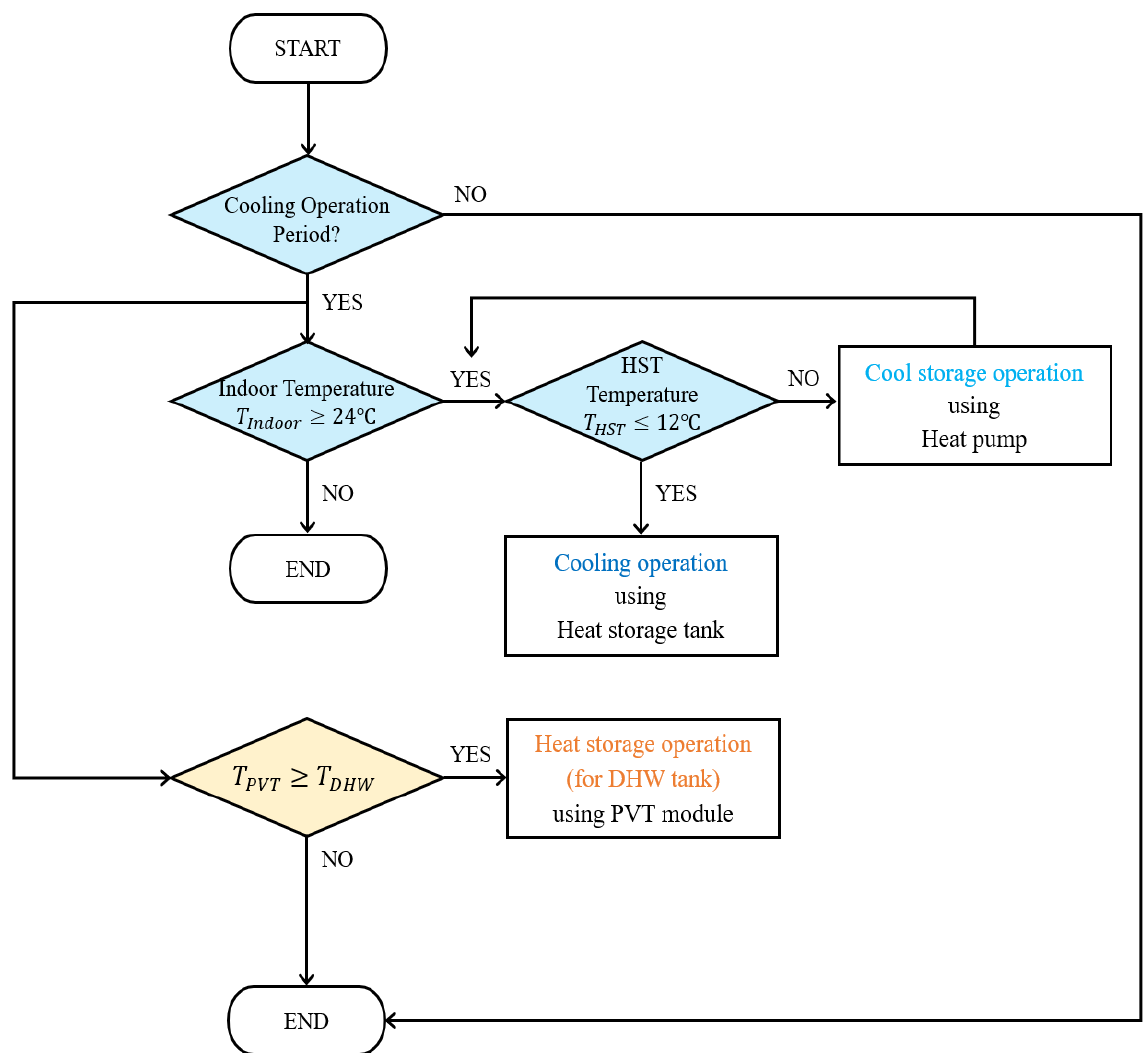
Table 2. U-value of the building load model.